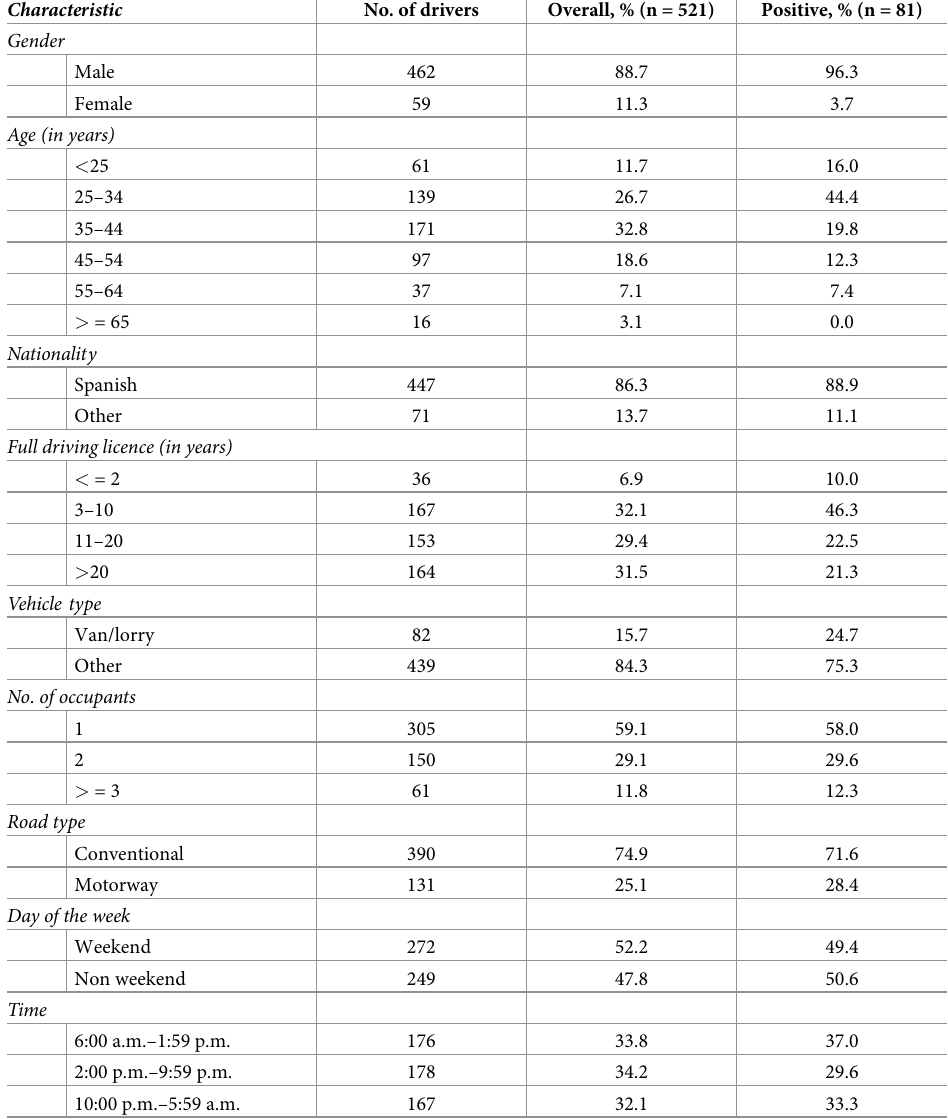
Table 1. Sample characteristics for drivers tested for